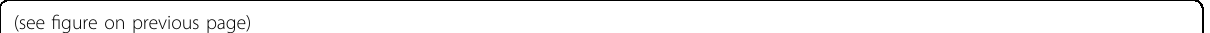
Fig. 4 A label-free quantitative proteomics screen identi fi es multiple ciliary proteins in the mammalian Ruvbl1 interactome. a Cloning strategy to generate an FlpIn NIH-3T3 cell line stably expressing a GFP.Ruvbl1 transgene. b The GFP.Ruvbl1 transgene showed nearly endogenous Ruvbl1 protein expression levels in stably integrated FlpIn NIH-3T3 cells compared with cells expressing a GFP.GFP transgene. c , d Analysis of the Ruvbl interactome ( n = 5). GFP.Ruvbl1 or GFP.Ruvbl2 were immunoprecipitated and analyzed by label-free quantitative proteomics. Seventy-six proteins had a signi fi cantly increased abundance in the GFP.Ruvbl1 immunoprecipitation (Ruvbl1) compared with the control (GFP) pulldown ( c ). Thirty-three proteins had a signi fi cantly increased abundance in the GFP.Ruvbl2 immunoprecipitation (Ruvbl2) compared with the control (GFP) pulldown ( d ). In the volcano plots, the signi fi cance between groups ( − log10 p value) is plotted against the log2 fold change between groups. Dots outside the curved line represent proteins with signi fi cantly increased abundance (FDR 0.01, s0 = 1). The corresponding data for the Ruvbl1/2 interactome can be found in Suppl. Tables S1 and S2. e Comparison of the Ruvbl1 and Ruvbl2 interactome. The Ruvbl2 interactome overlapped with proteins identi fi ed as Ruvbl1 interactors. f Stoichiometry analysis of Ruvbl1 and Ruvbl2 interactors. iBAQ values were normalized to Ruvbl2 to obtain an estimation of the absolute abundances of proteins within the puri fi ed complex. The ten most abundant proteins in the Ruvbl1 interactome are depicted. # marks proteins previously associated with cilia. g STRING network visualization of the Ruvbl1 interactome demonstrated a prominent representation of ciliary proteins (violet = identi fi ed in Centrosome and Cilium Database (CCDB), blue = not identi fi ed in CCDB). h Gene ontology (GO) term overrepresentation analysis of Ruvbl1 interactors compared with non-enriched proteins ( “ background binding proteins ” ). Fold enrichment of the signi fi cantly enriched GO terms is plotted for GO-MF (molecular function, black bars), GO-CC (cellular compartment, gray bars), and GO-BP (biological process, white bars) terms. Statistical enrichment was performed using a Fisher ’ s exact test (FDR <